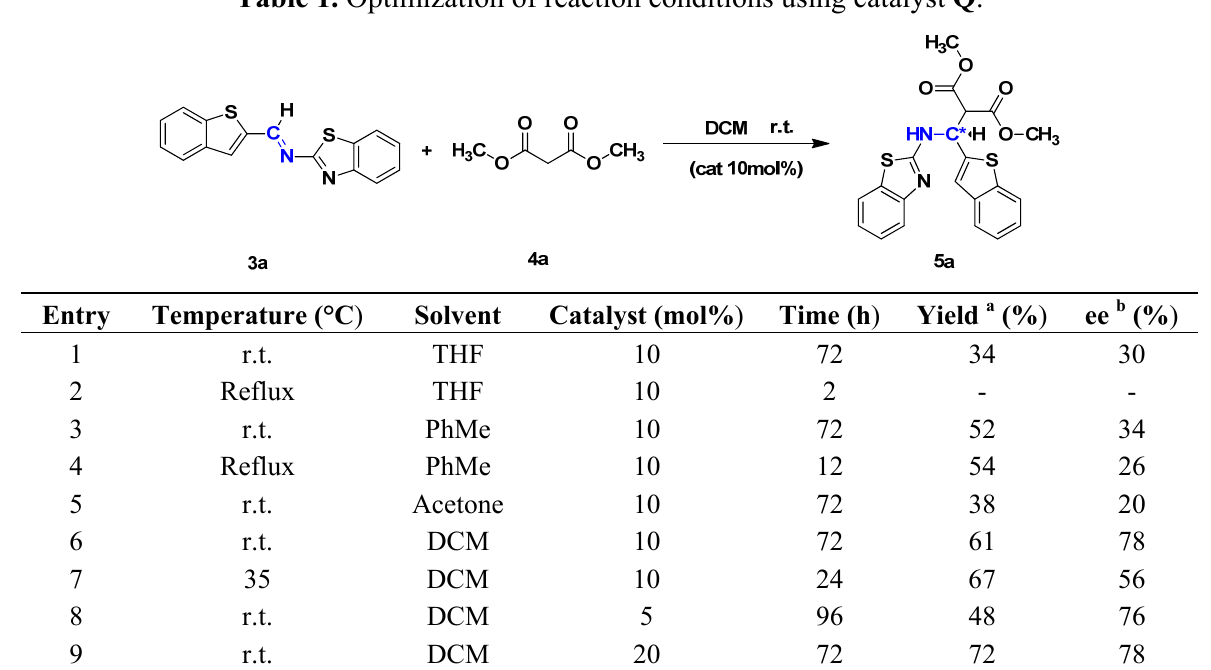
Table 1. Optimization of reaction conditions using catalyst Q .